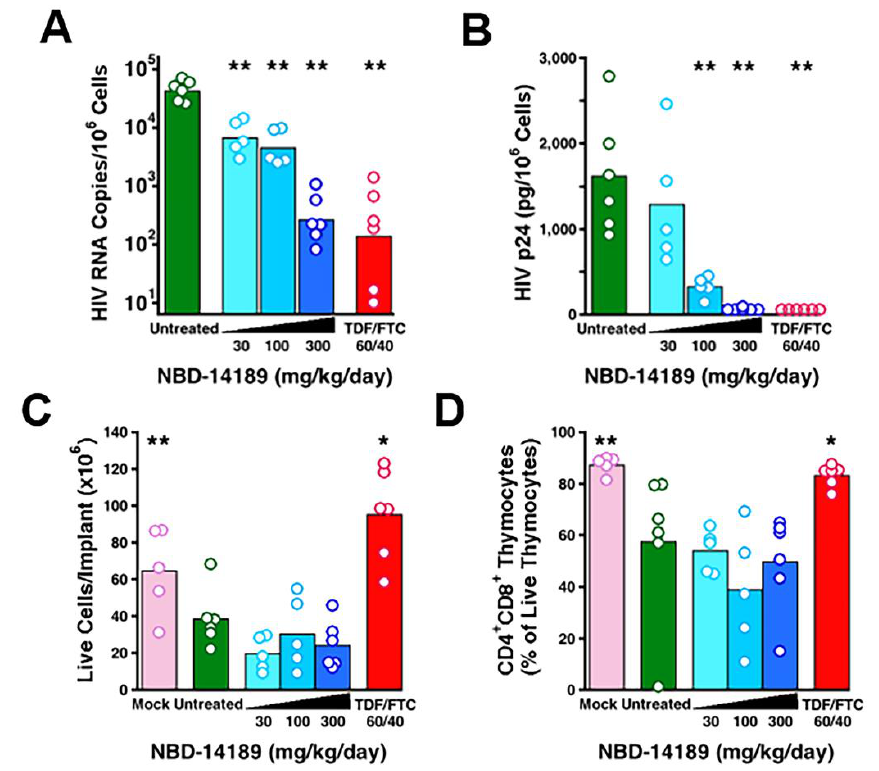
Figure 6. Treatment of SCID-hu Thy/Liv mice with NBD-14189 caused dose-dependent reductions in HIV RNA ( A ) and undetectable p24 ( B ) in 5 of 6 mice at 300 mg/kg/day. Despite this apparent evidence of antiviral activity by treatment with NBD-14189, there was no apparent protection from HIV-mediated reductions in total implant cellularity ( C ) or from virus-mediated depletion of CD4 + CD8 + thymocytes ( D ) 21 days after inoculation. *, p < 0.05; **, p < 0.01 (compared to untreated mice by Mann–Whitney U test).